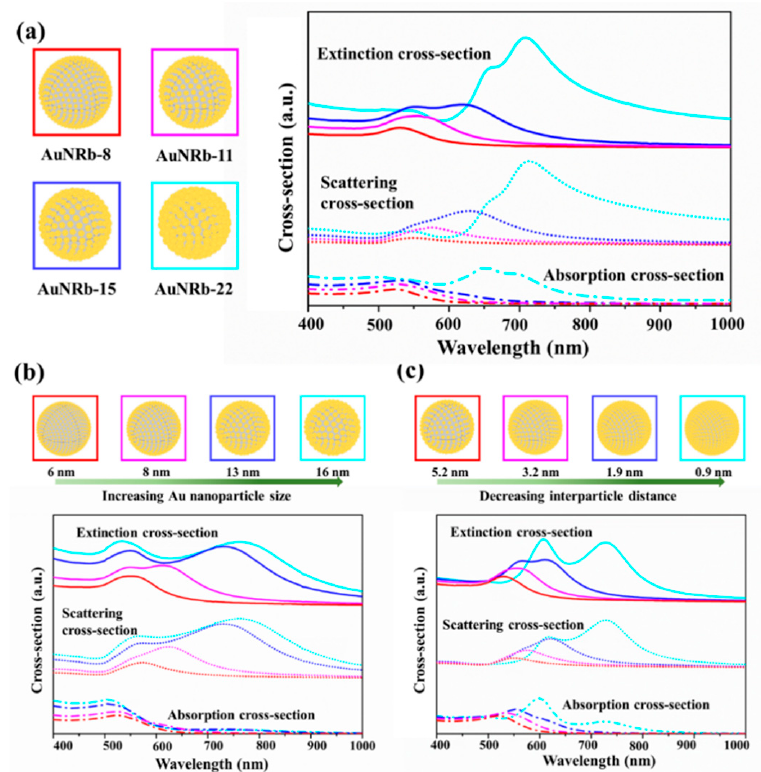
Figure 3. ( a ) The calculated absorption cross-sections, scattering cross-sections and extinction cross-sections of AuNRb-8 (red), AuNRb-11 (magenta), AuNRb-15 (blue) and AuNRb-22 (cyan). The extinction cross-section is the sum of the absorption cross-section and the scattering cross-section. ( b ) The dependence of cross-sections as a function of the nanoparticle size when the interparticle distance is kept at 4 nm. The sizes of the nanoparticles used in simulation increased from 6 nm (red) to 8 nm (magenta), 13 nm (blue) and 16 nm (cyan). ( c ) The dependence of cross-sections as a function of the interparticle distance when the nanoparticle size is kept at 10 nm. The interparticle distances of the nanoparticles used in simulation decreased from 5.2 nm (red) to 3.2 nm (magenta), 1.9 nm (blue) and 0.9 nm (cyan). The models used in simulation are displayed in boxes with border colors representing different conditions.